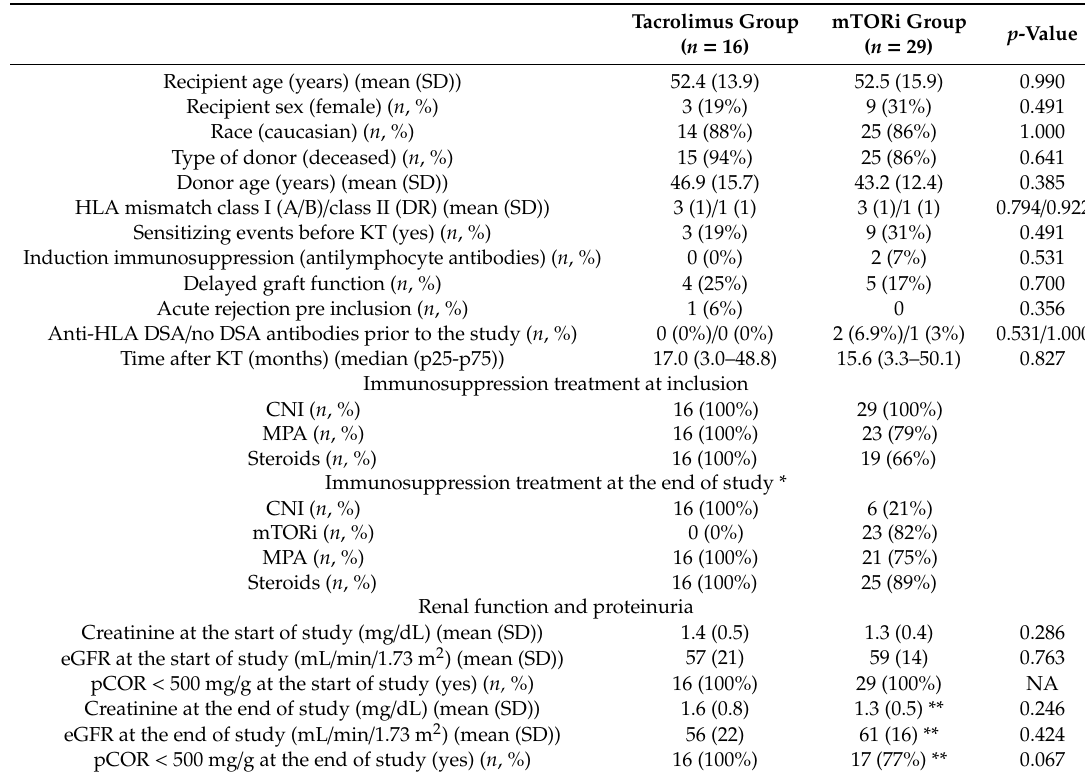
Table 1. Baseline and clinical follow-up characteristics of included patients: The table summarizes baseline characteristics and the clinical follow-up in patients switching from tacrolimus to serine / threonine protein kinase mechanistic target of rapamycin inhibitors (mTORi group) and patients maintaining tacrolimus (Tacrolimus